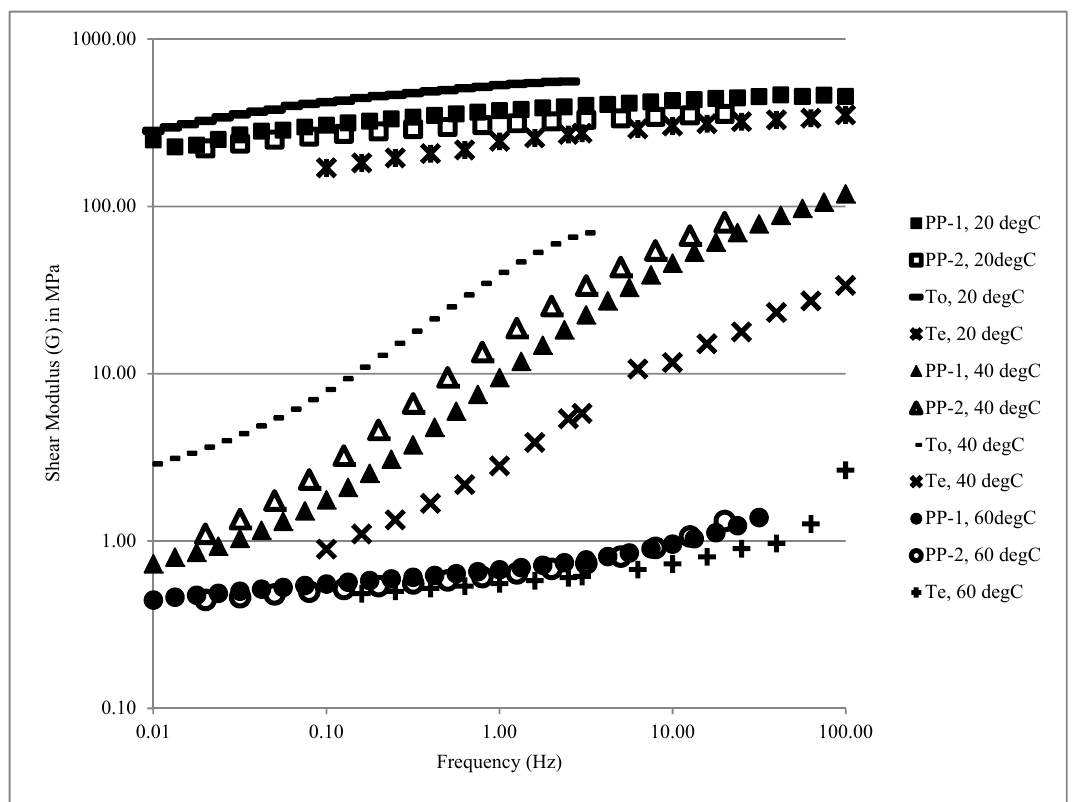
Fig. 6 Characterization of Saflex® DG41 interlayer using three different deformation modes (PP refers to plate/plate geometry, Te to tensile geometry, To to torsion geometry)